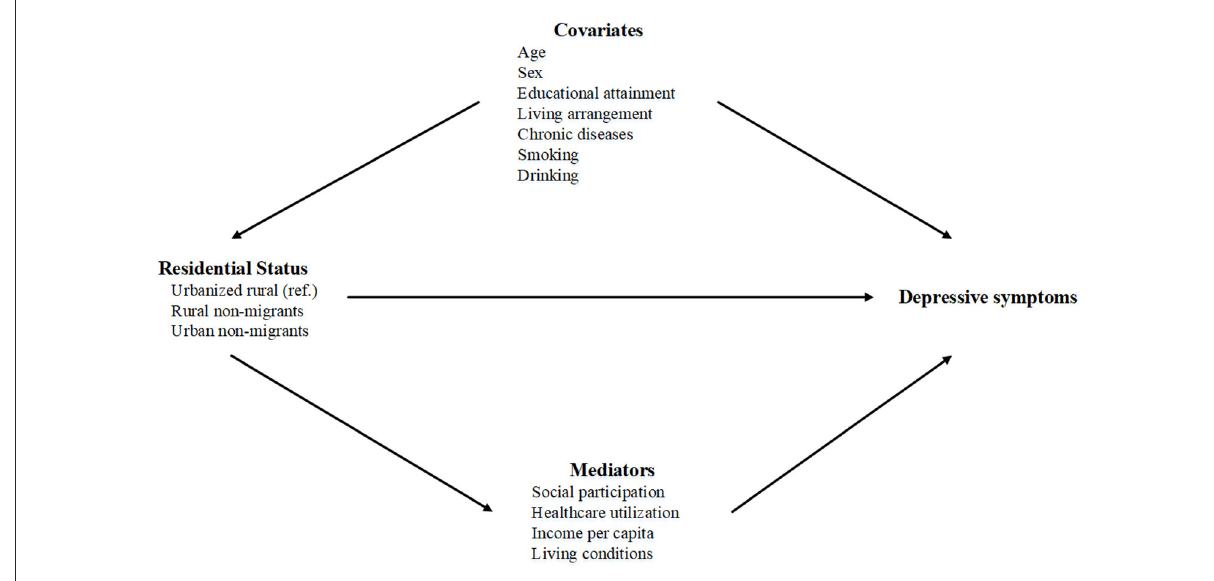
FIGURE2 Directed acyclic graph (DAG) of the mediation